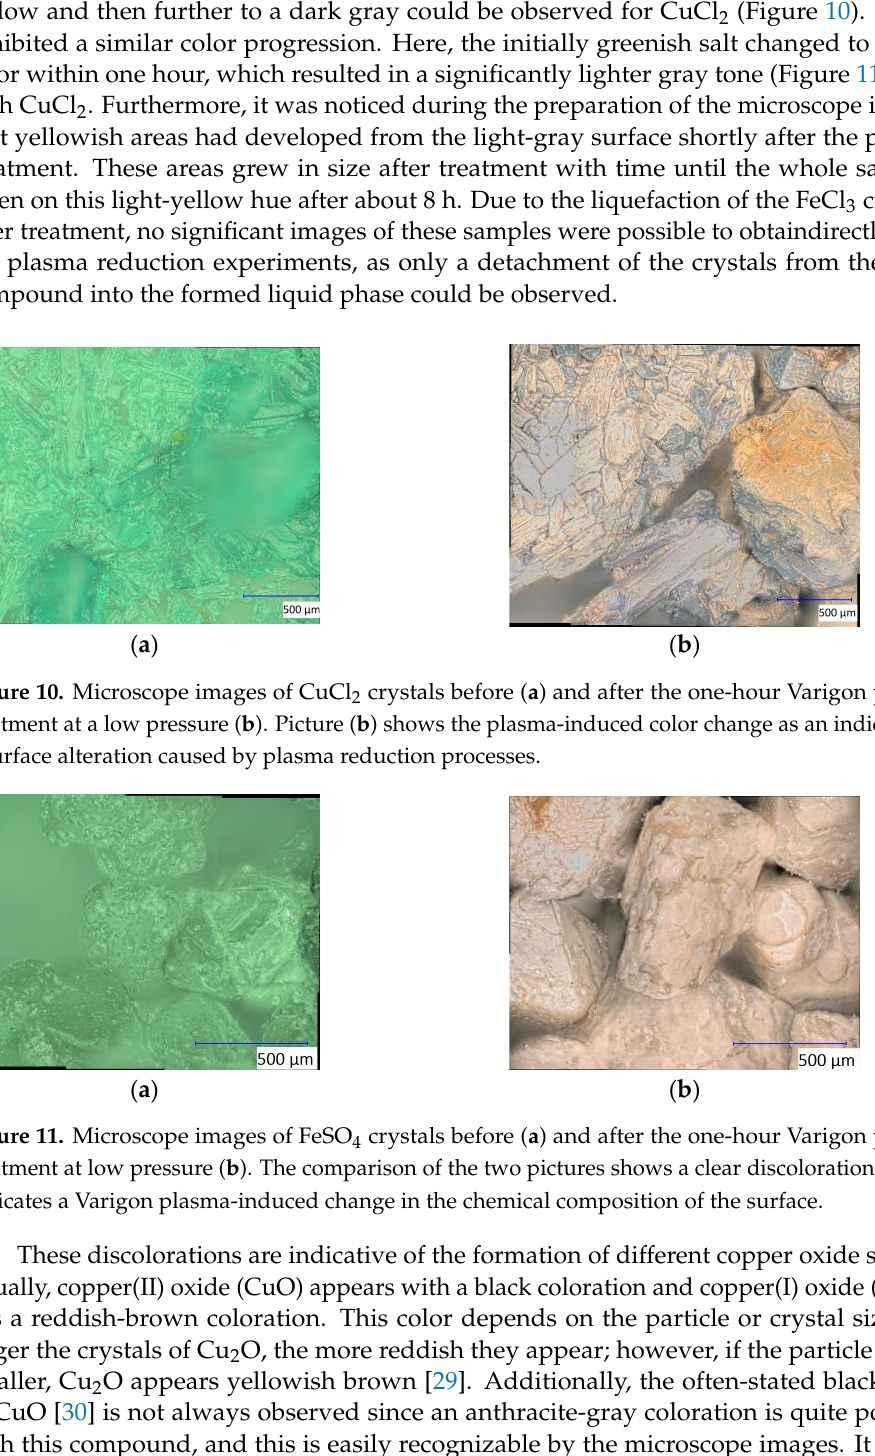
Figure 9 . FeCl 3 · 6 H 2 O crystals before ( a ) and after 30 min reductive Varigon low-pressure treatment ( b ). As can be seen in picture ( b ), the plasma caused a liquefaction of the crystalline starting material.